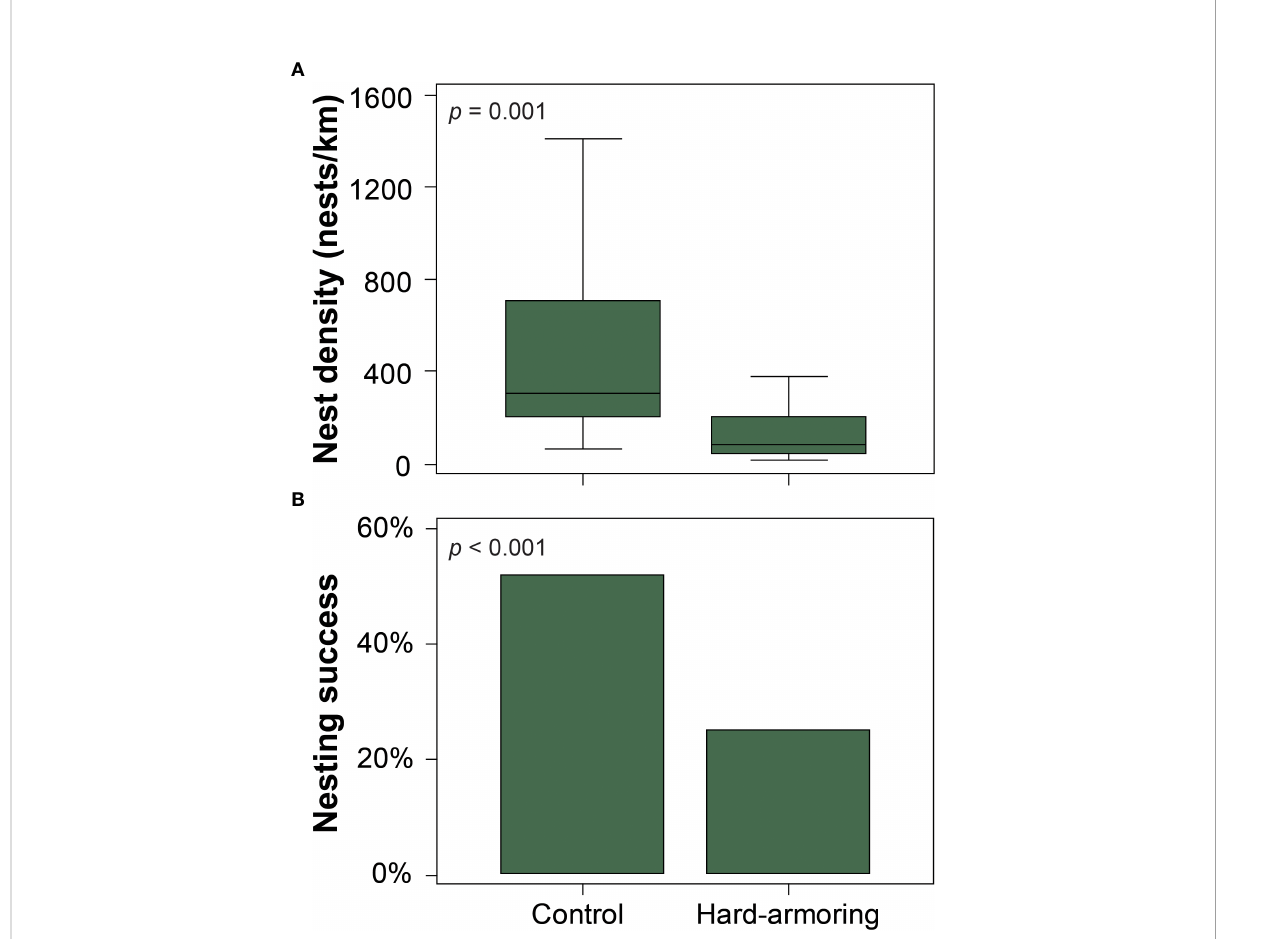
FIGURE 5 (A) Nest density and (B) nesting success were signi fi cantly lower at the hard-armoring structures in comparison to the control site for nesting green sea turtles ( Chelonia mydas ) on Tequesta and Jupiter Inlet Colony Beaches, Florida, USA. For panel (A) , the middle line represents the median, the boxes represent the fi rst and third quartiles, while the whiskers represent the